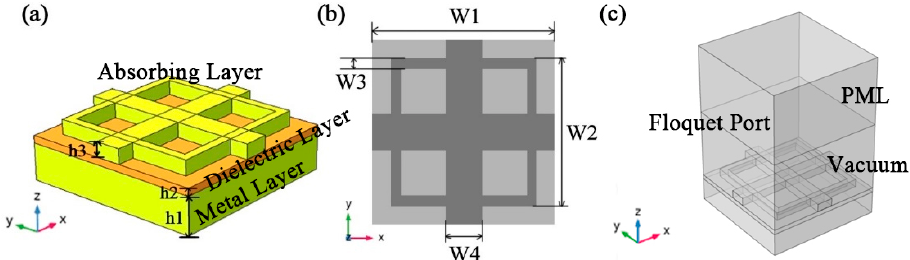
Figure 1. Schematic diagram of the base absorber: ( a ) schematic diagram of the three-dimensional structure of the ultra-broadband solar absorber. ( b ) Top view of the absorber structure. (c) the perfect matching layer (PML) of the base absorber.